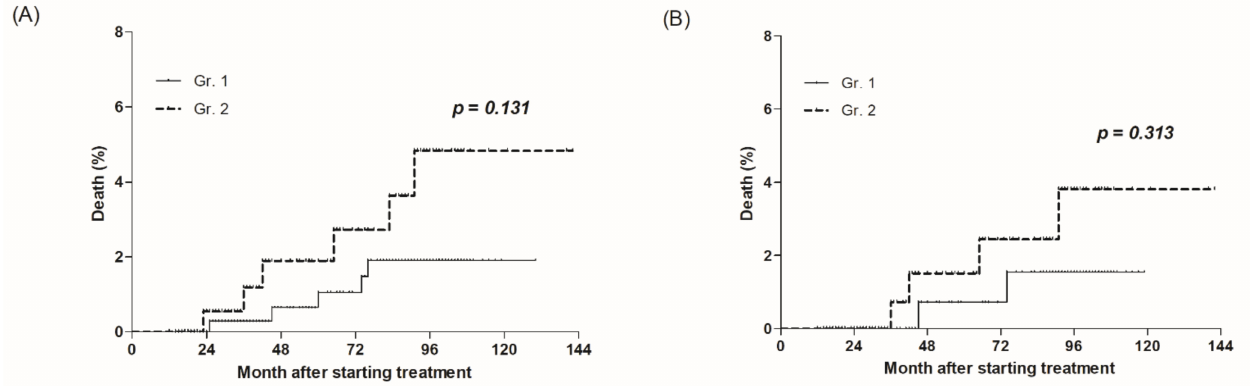
Figure 1. All-cause mortality according to early on-treatment ALT normalization. ( A ) A total of 610 patients, and ( B ) 378 patients after propensity